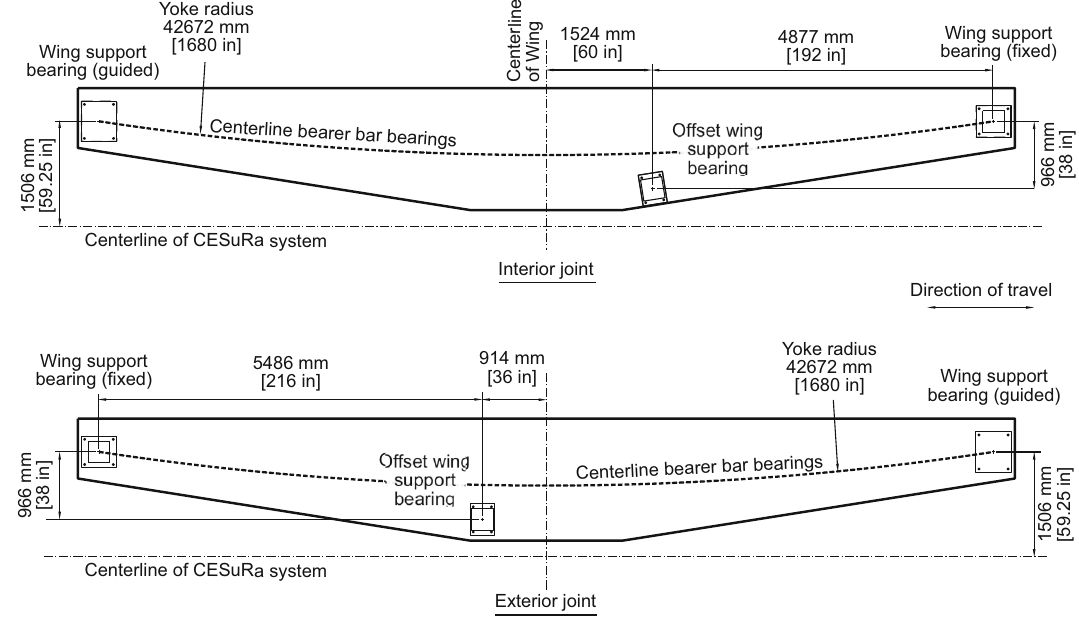
Fig. 13 Wing Geometry used on the Homer M. Hadley